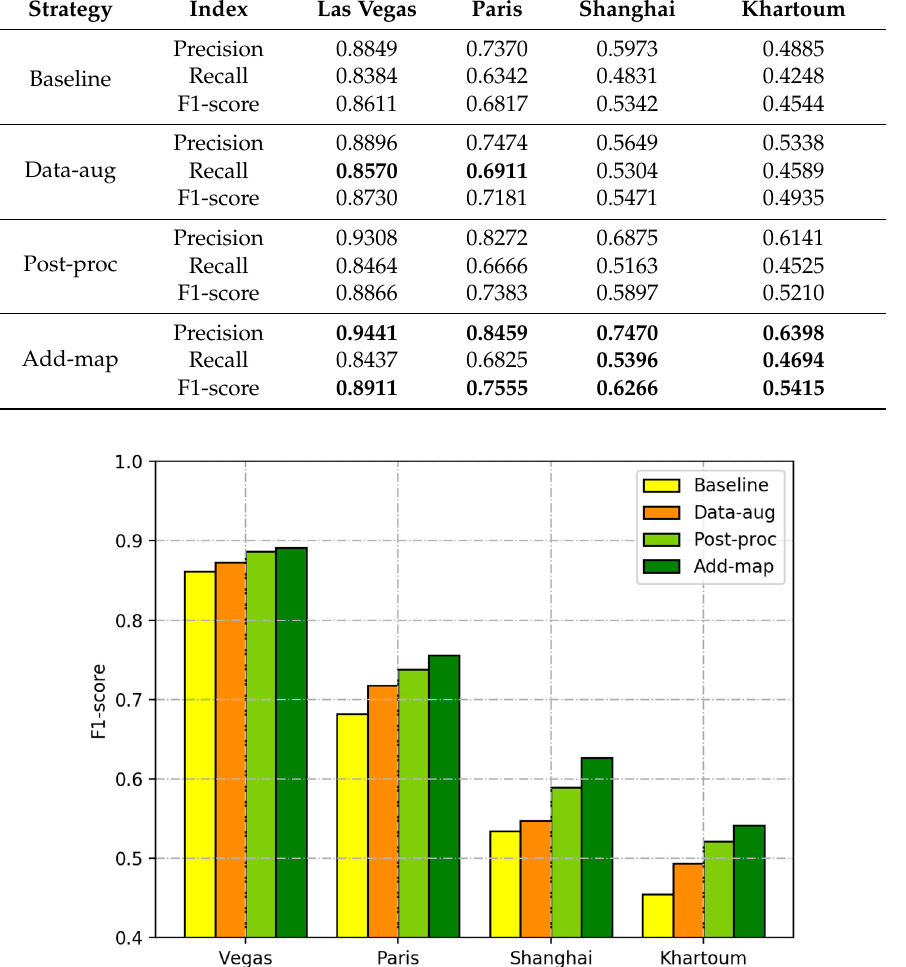
Figure 5. F1-scores obtained after applying different strategies of our proposed method.